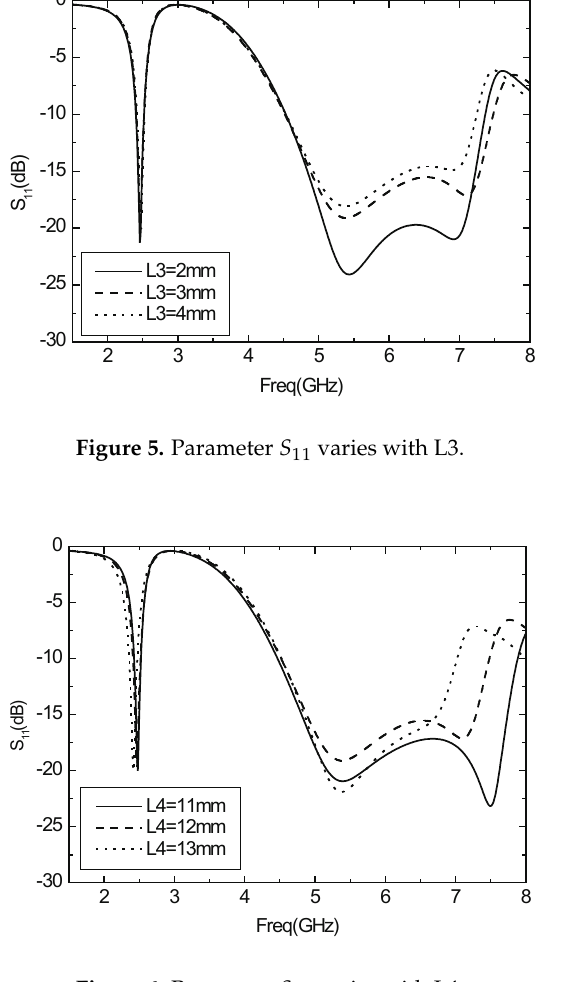
Figure 6. Parameter S 11 varies with L4.